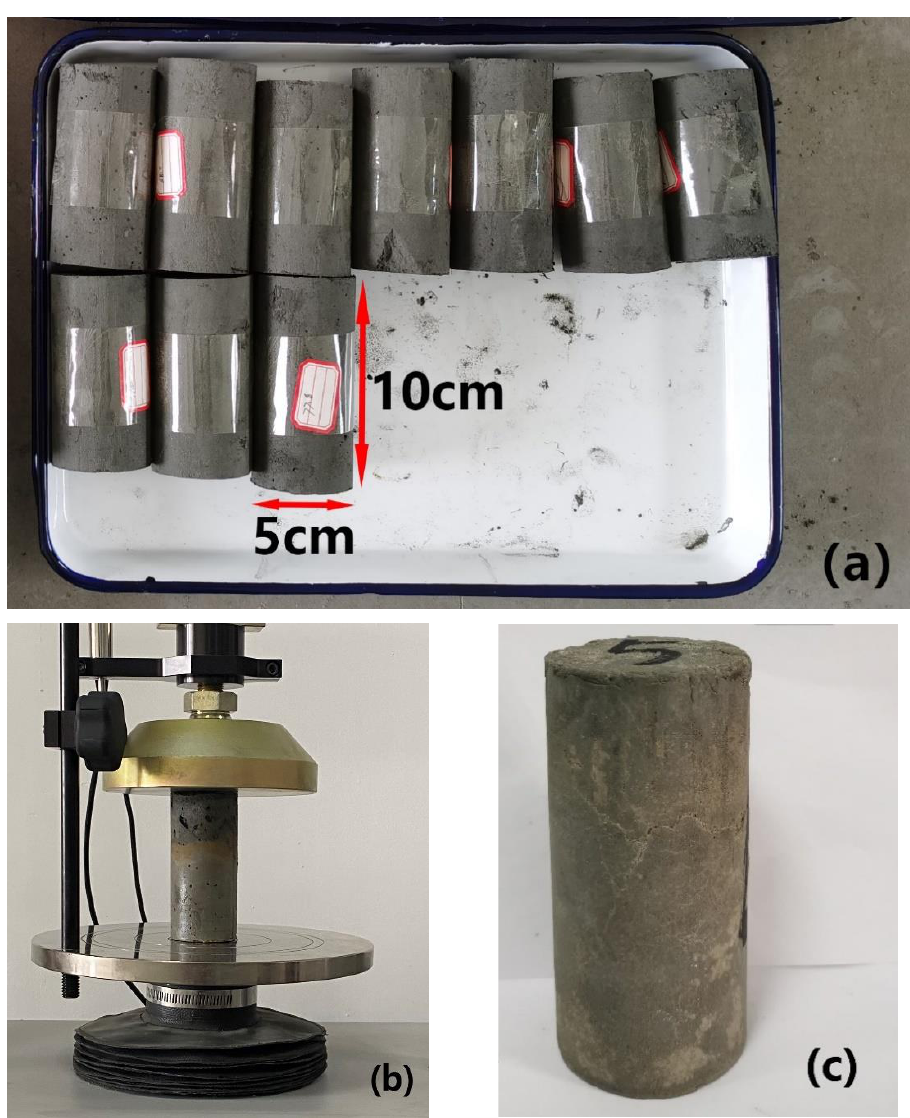
Figure 5. The cemented tailings backfill (CTB) specimens drilled from different areas after the flume test. ( a ) The specimens obtained; ( b ) the uniaxial compressive strength (UCS) testing process; ( c ) the specimen after failure.